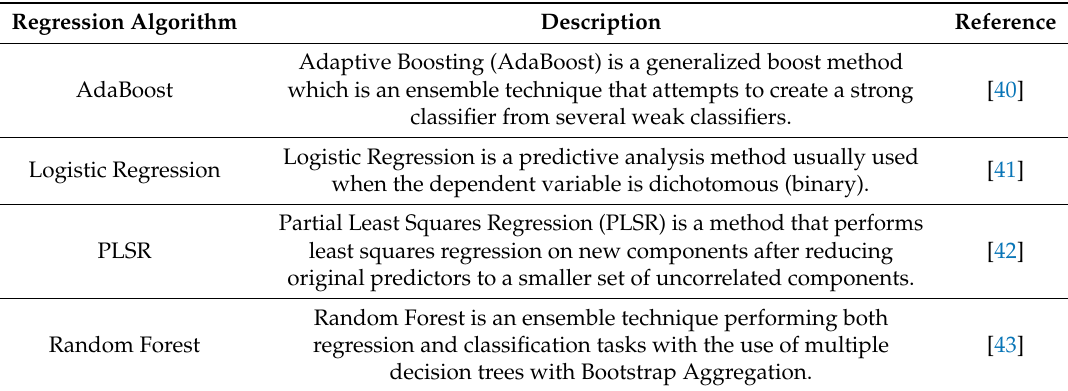
Table 2. Overview of machine learning algorithms used for this